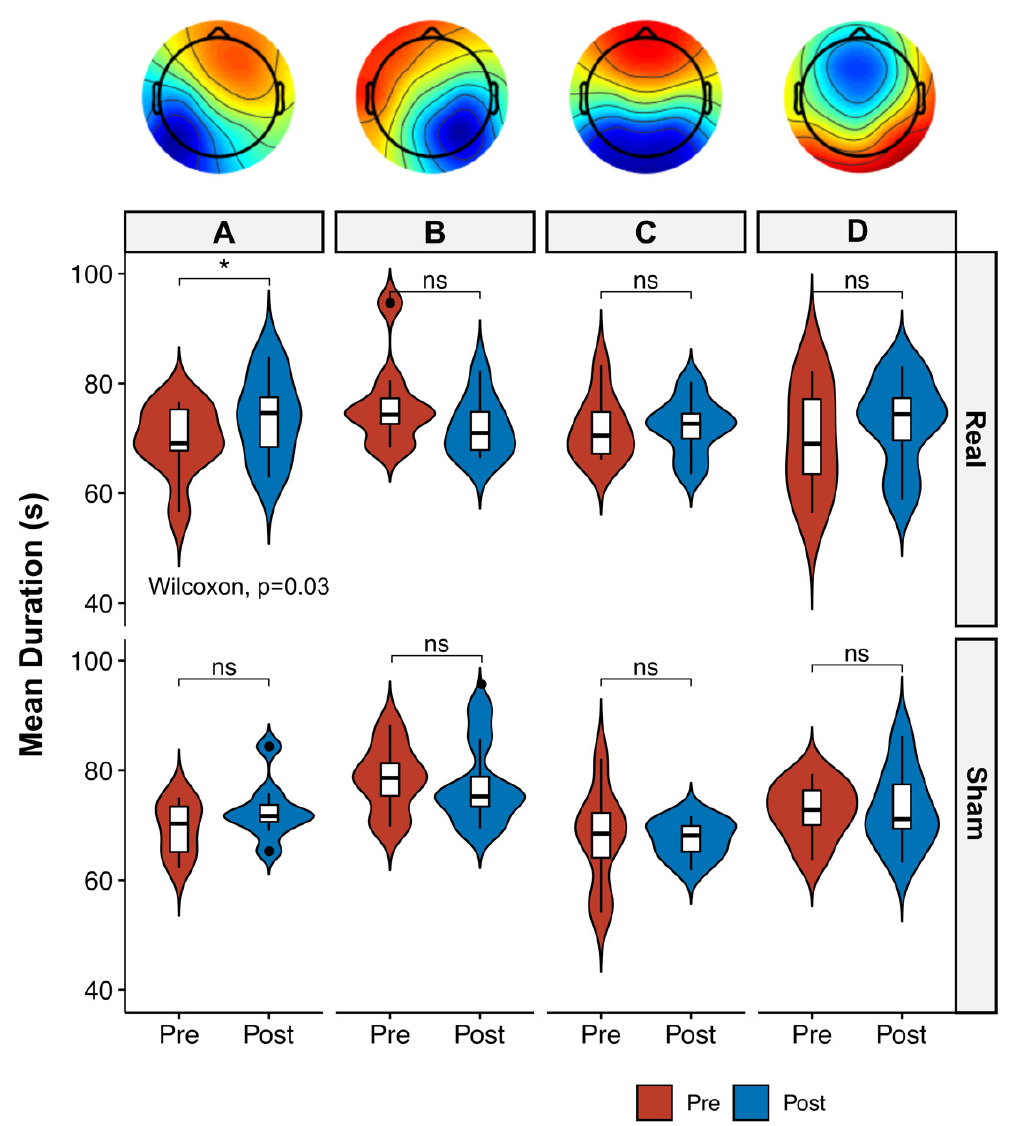
Figure 3. Boxplot and violin plot distributions of mean duration of the four microstate templates across time (Pre vs. Post) and conditions (Real vs. Sham). Circles denote values that are farther than 1.5 interquantile ranges. Microstate maps (from A to D , upper panel) represent the global microstate templates obtained from condition-wise microstate template. The A map was significantly longer in duration after Real tVNS stimulation, as opposed to Sham tVNS stimulation, which failed to reveal any significant difference. * = p < 0.05, ns = not significant.